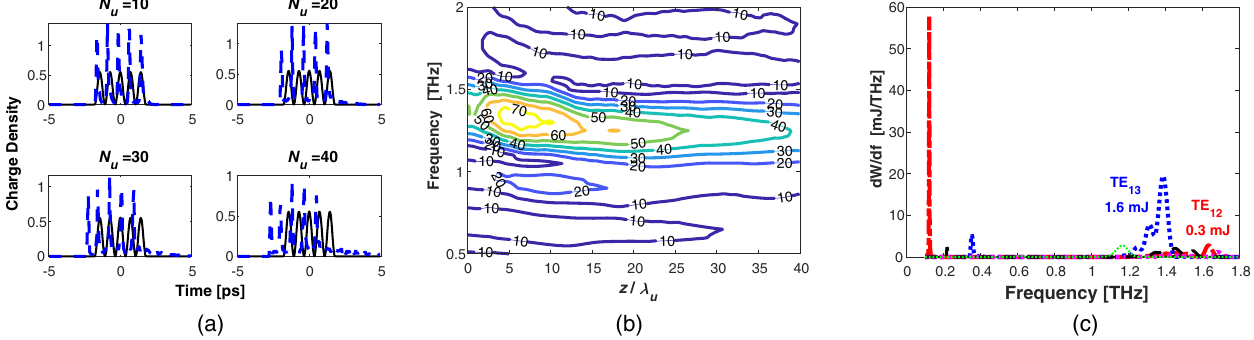
FIG. 6. Bunch with a charge of 2.5 nC and five periods of unity modulation at a frequency of 1.4 THz in NMI regime (over-resonance guiding field of 75 kG): (a) charge density after 10 to 40 undulator periods, (b) contours of the bunching factor, and (c) radiation spectrum after 40 undulator periods.